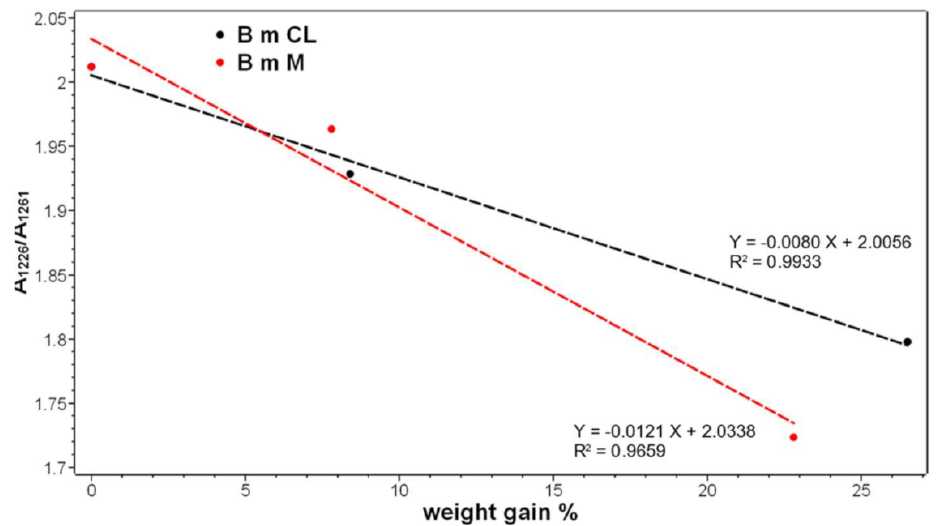
Figure 7. Trend of the A 1226 /A 1261 IR absorbance ratio as a function of the weight gain for the silk fibroin fabrics grafted with phosmer CL (black) and phosmer M